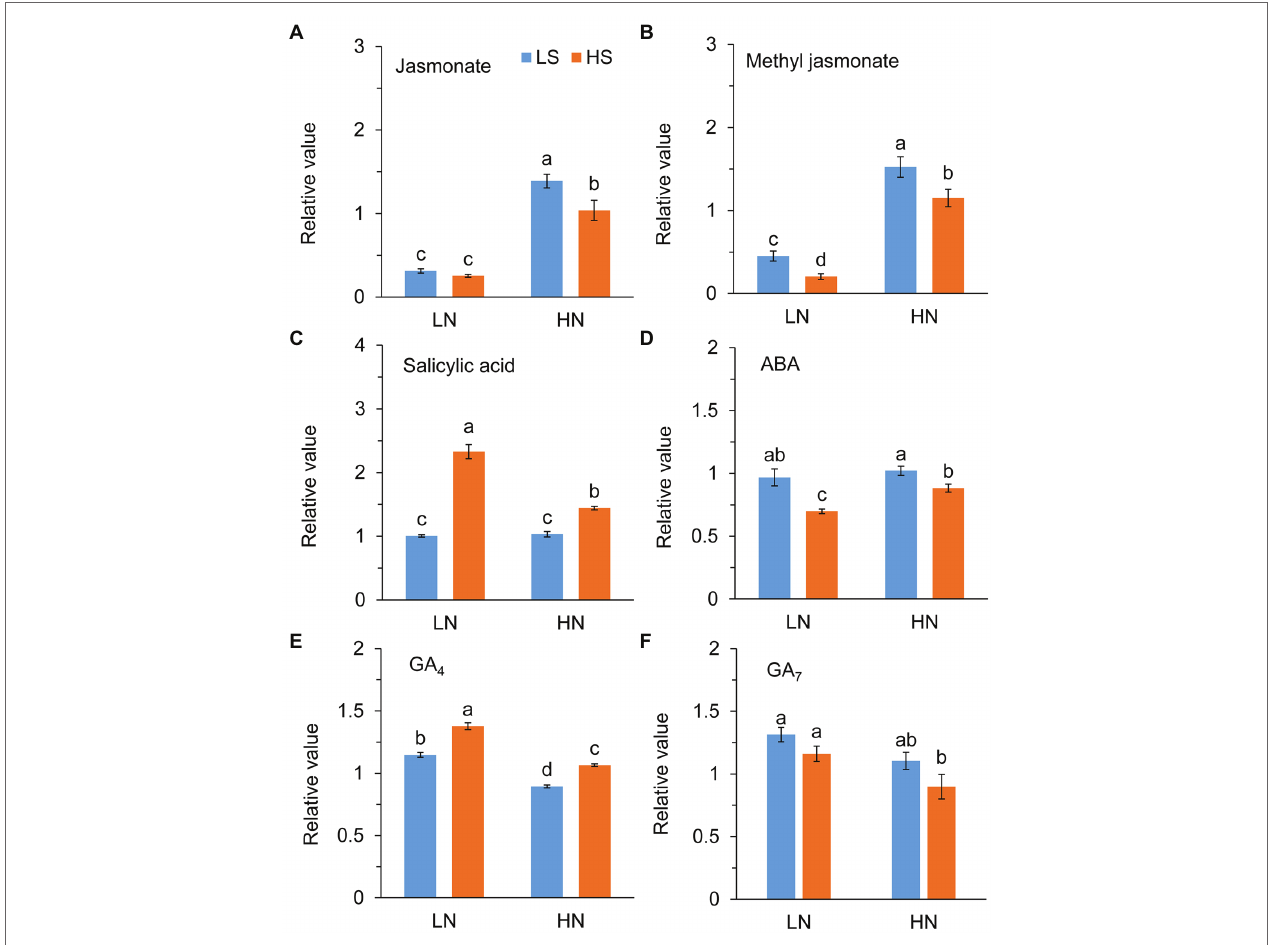
FIGURE 6 | Phytohormones in leaves of A. paniculata plants grown under different nitrogen and sulfur conditions. (A) Relative value of jasmonate. (B) Relative value of methyl jasmonate. (C) Relative value of salicylic acid. (D) Relative value of abscisic acid (ABA). (E) Relative value of gibberellic acid 4 (GA 4 ). (F) Relative value of gibberellic acid 7 (GA 7 ). Data were presented as mean ± SE ( n = 4). Different letters on the bars indicate significant difference among treatments at p < 0.05 using the method of LSD . LN, low nitrogen; HN, high nitrogen; LS, low sulfur; HS, high sulfur.